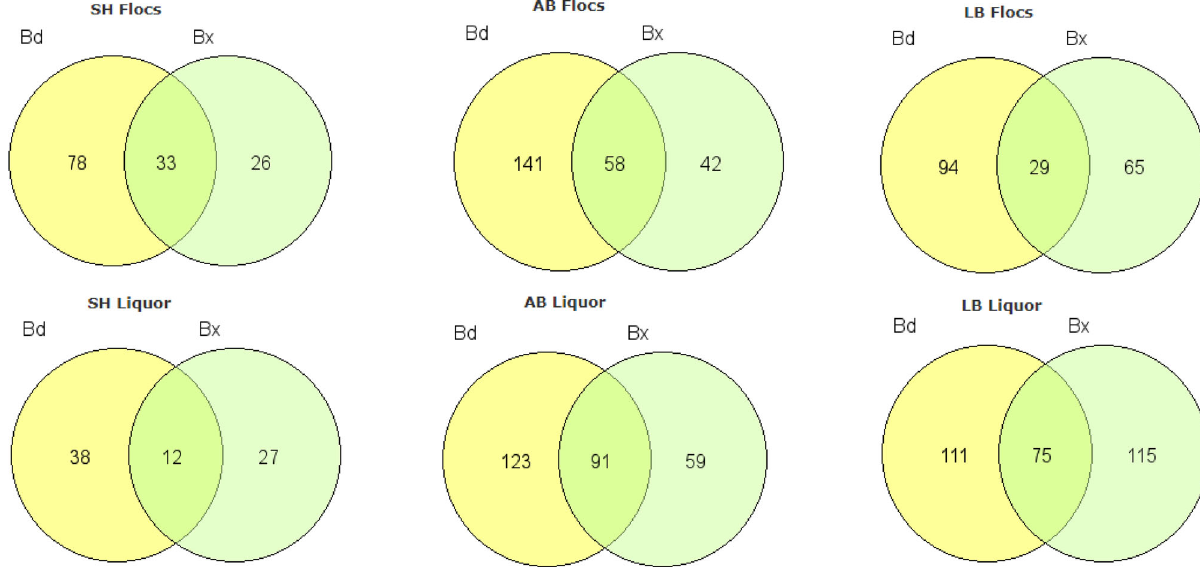
Fig. 6 BALO prey ranges. Prey range overlap (shared OTUs) between Bdellovibrionales (Bd) and Bacteriovoracales (Bx) in the fl oc and in the liquor fractions at the Shafdan (SH), Al-Bireh (AB), and Langenreichenbach (LB) WWTPs.